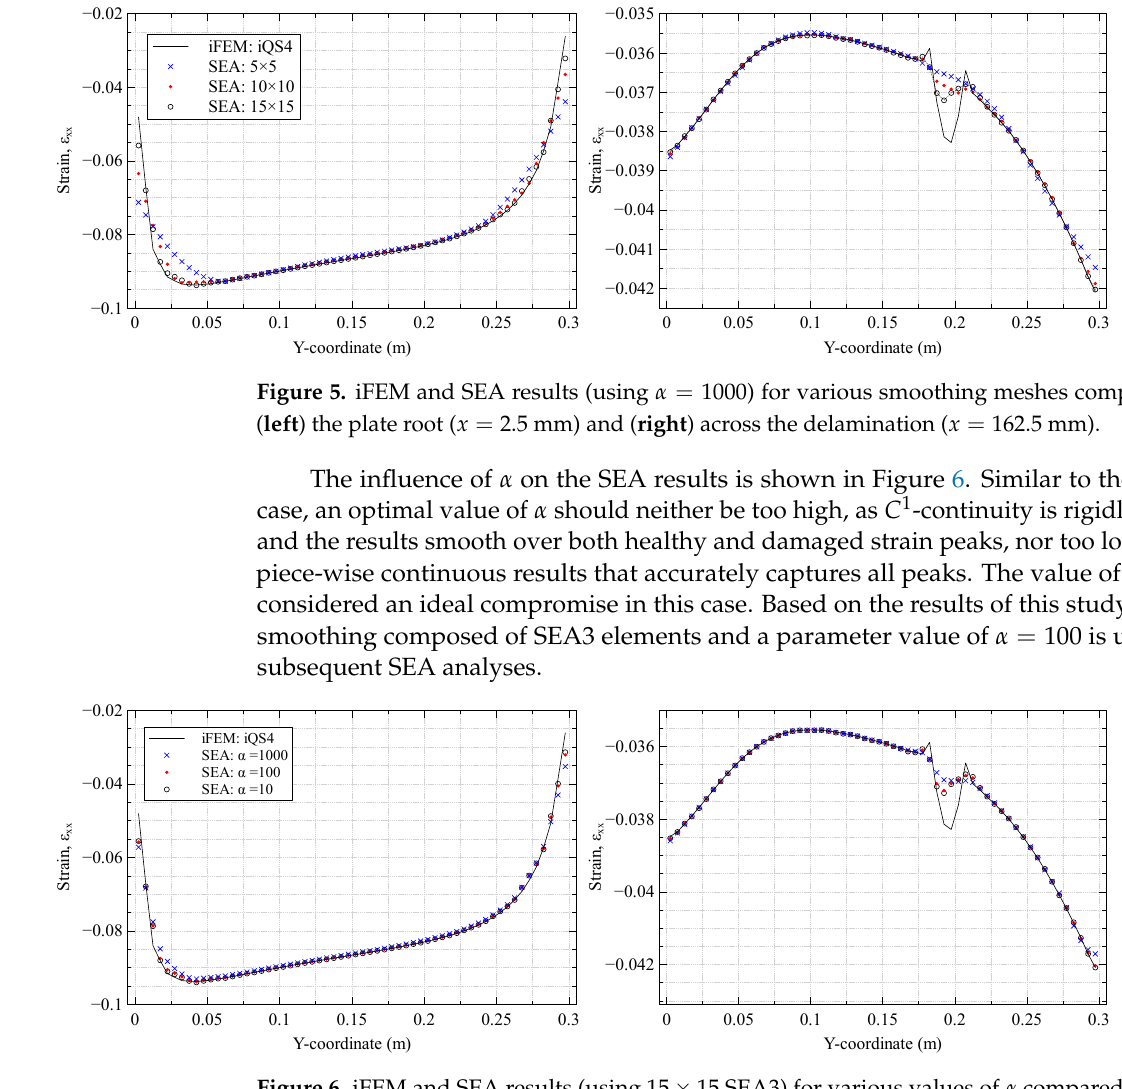
Figure 6. iFEM and SEA results (using 15 × 15 SEA3) for various values of α compared along ( left ) the plate root ( x = 2.5 mm) and ( right ) across the delamination ( x = 162.5